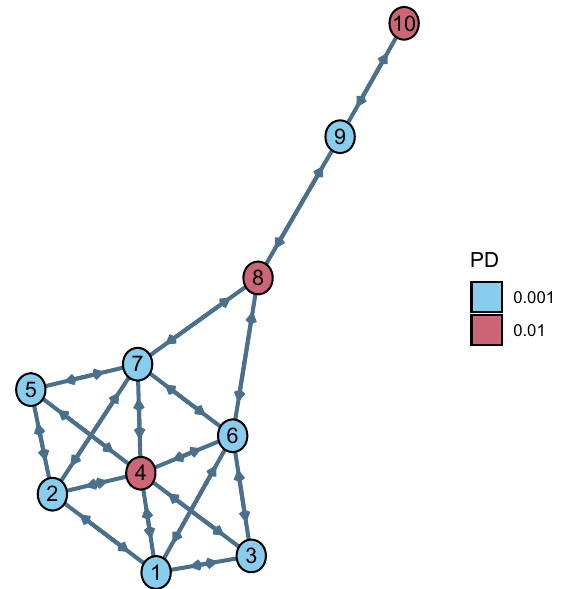
Fig. 1 | Krackhardt Kite (KK) network. The KK network is used to assess how bailout decisions are in fl uenced by node centrality. The ten nodes of the graph in I = f 1, ... ,10 g represent fi nancial institutions, which are identical apart from their probabilities of default(PD)attime 0,which are PD i (0)=0.01,for i ∈ {4, 8,10},and PD i (0)=0.001, for i 2 I n f 4,8,10 g . They all have a normalised total asset W i (0)= 100 and capital E i (0)=3. The edges between nodes, representing claims between fi nancialinstitutions,areorientedandhomogeneous,assumingthevalue w ij =1,for all i ≠ j 2 I